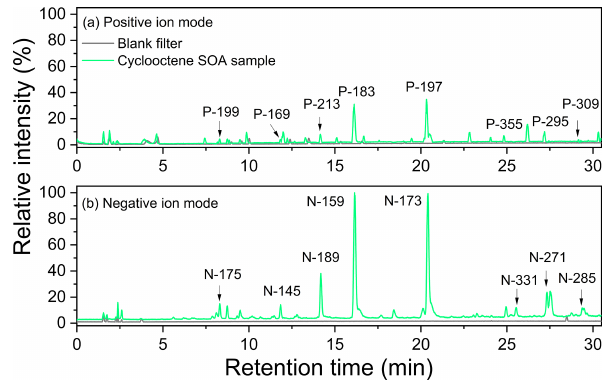
Figure 3. Base peak chromatograms of both blank filter and parti- cles generated from the ozonolysis of cyclooctene in the absence of SO 2 . Labels represent the most abundant single ion of each peak. (a) Positive ion mode. (b) Negative ion